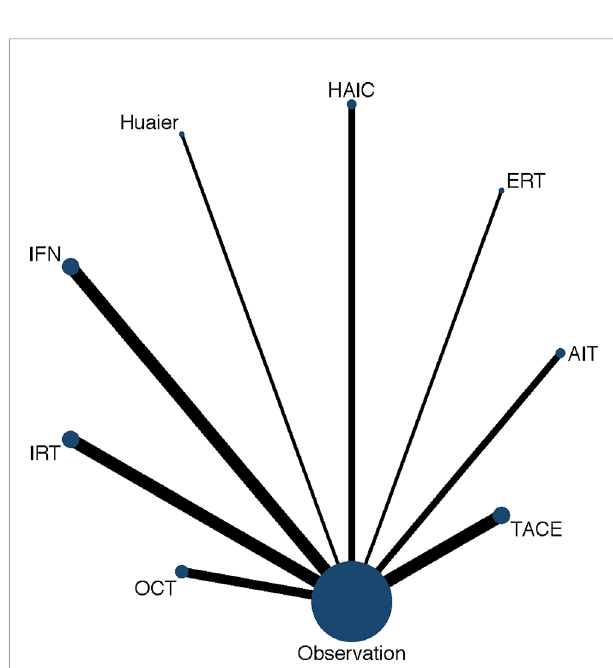
FIGURE 3 | Network diagram of eligible comparisons for OS. Each circular node represents a variety of interventions. The circle size is proportional to the number of randomly assigned participants. The width of lines between the nodes is proportional to the number of trials performing head-to-head comparisons. AIT, adoptive immunotherapy; ERT, external radiotherapy; HAIC, hepatic artery infusion chemotherapy; IFN, interferon; IRT, internal radiotherapy; OCT, oral chemotherapy; TACE, transarterial